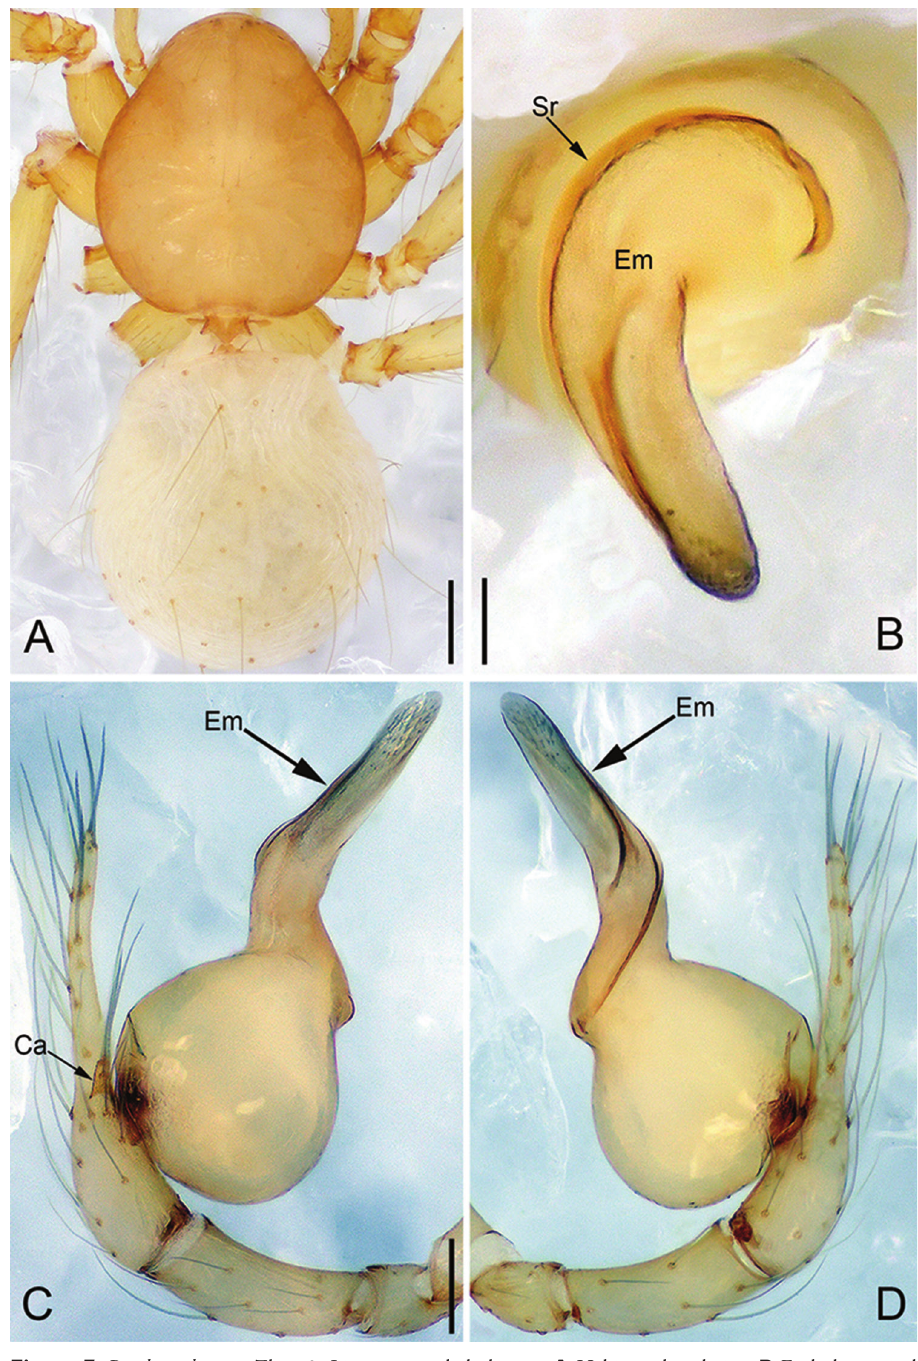
Figure 7. Pinelema huoyan Zhao & Li, sp. n., male holotype. A Habitus, dorsal view B Embolus, apical view C Palp, prolateral view D Palp, retrolateral view. Scale bars: 0.2 mm ( A ), 0.05 mm ( B ), 0.1 mm ( C–D